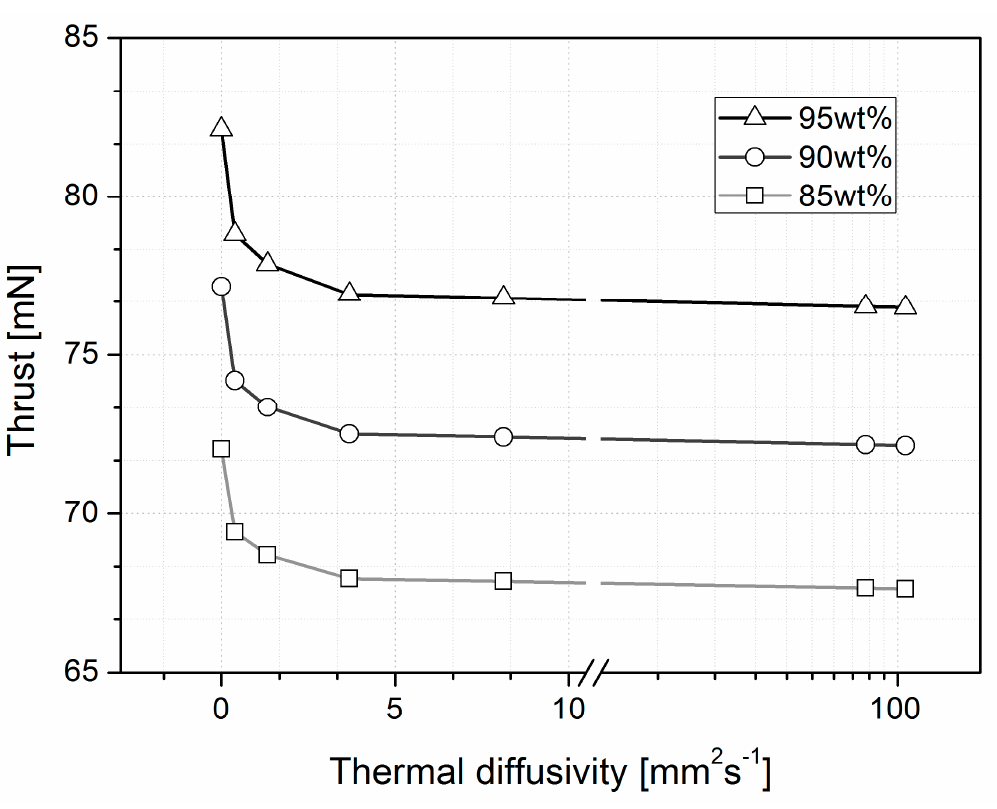
Figure 13. Thrust generation of microthrusters with different thermal diffusivity materials and different propellant weight percentages.